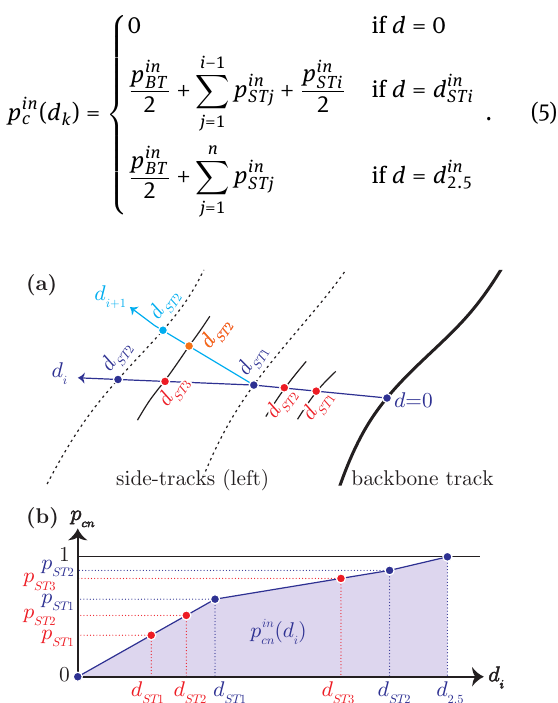
Figure 1: (a) Illustration of the calculation of the distance along combinations paths – here both the dark blue and light blue curves represent combinations paths ( i and i + 1 respectively) – achieved by adding linear segments between the matching points on the subtracks (matching points in dark and light blue, backbone track as a bold black line, and initial side-tracks as dotted black lines). The newly constructed subtracks are shown in black, with the created points in red/orange. (b) Cumulative lateral distribution function p cn ( d ) for the combination path i from (a), as well as the solutions to equation 7, i.e. the newly created points on the new subtracks, in